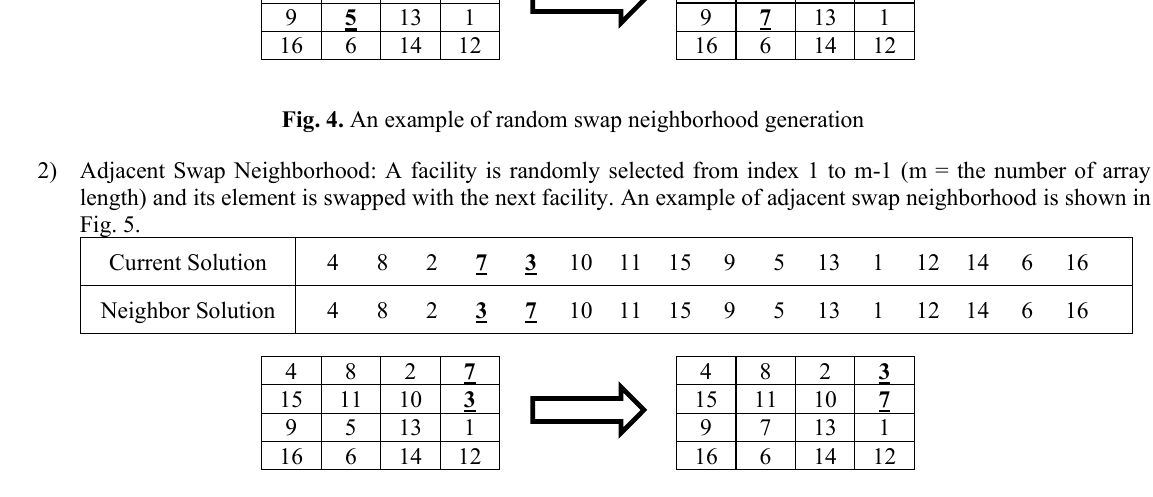
Fig. 5. An example of adjacent swap neighborhood